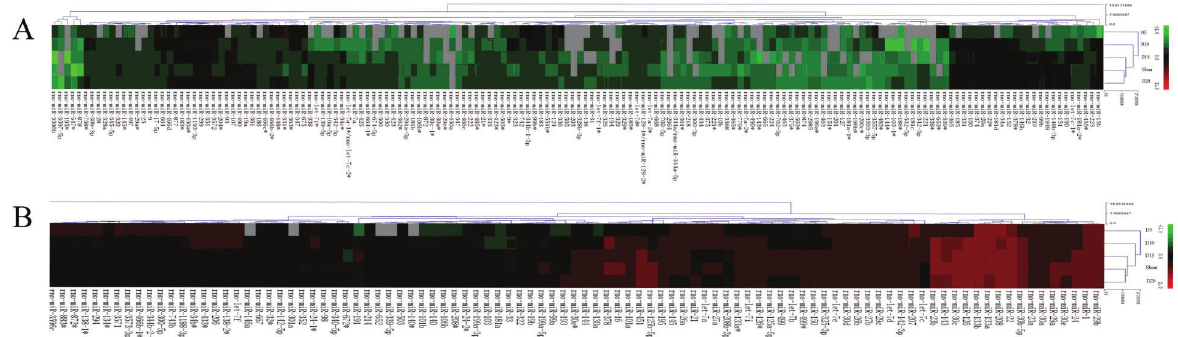
Figure 2. Heat maps of the global expression of miRNAs during hypertrophy. A , Upregulated miRNAs; B , downregulated miRNAs during